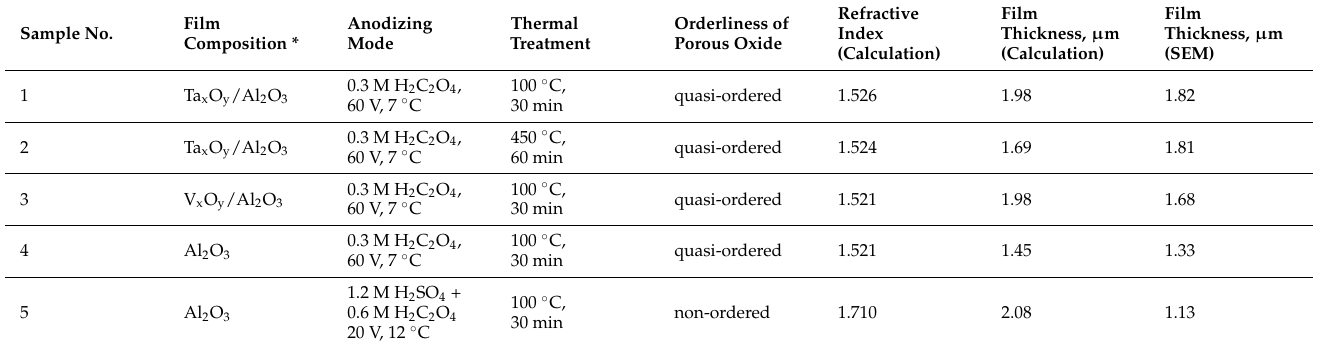
Table 1. Composition, synthesis mode, and physical properties of investigated porous anodic oxide